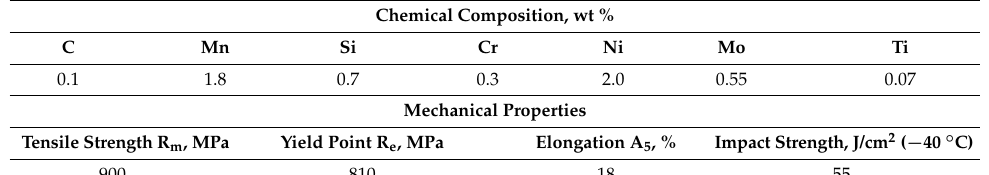
Table 2. Chemical composition and mechanical properties of filler metal GMn4Ni1.5CrMo.